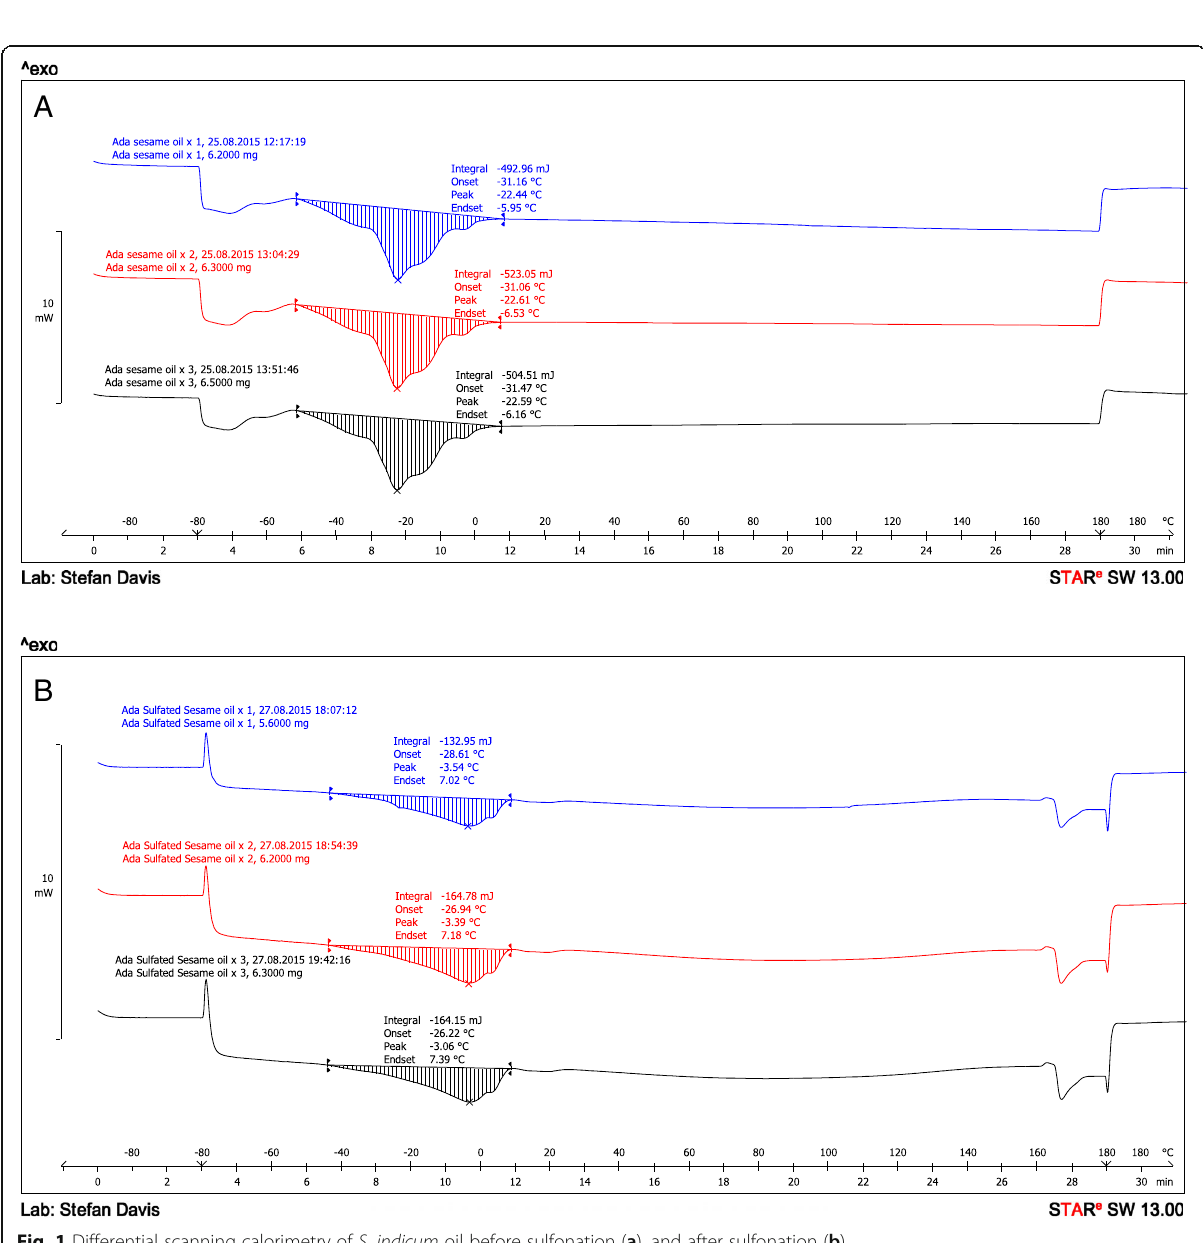
Fig. 1 Differential scanning calorimetry of S. indicum oil before sulfonation ( a ), and after sulfonation ( b